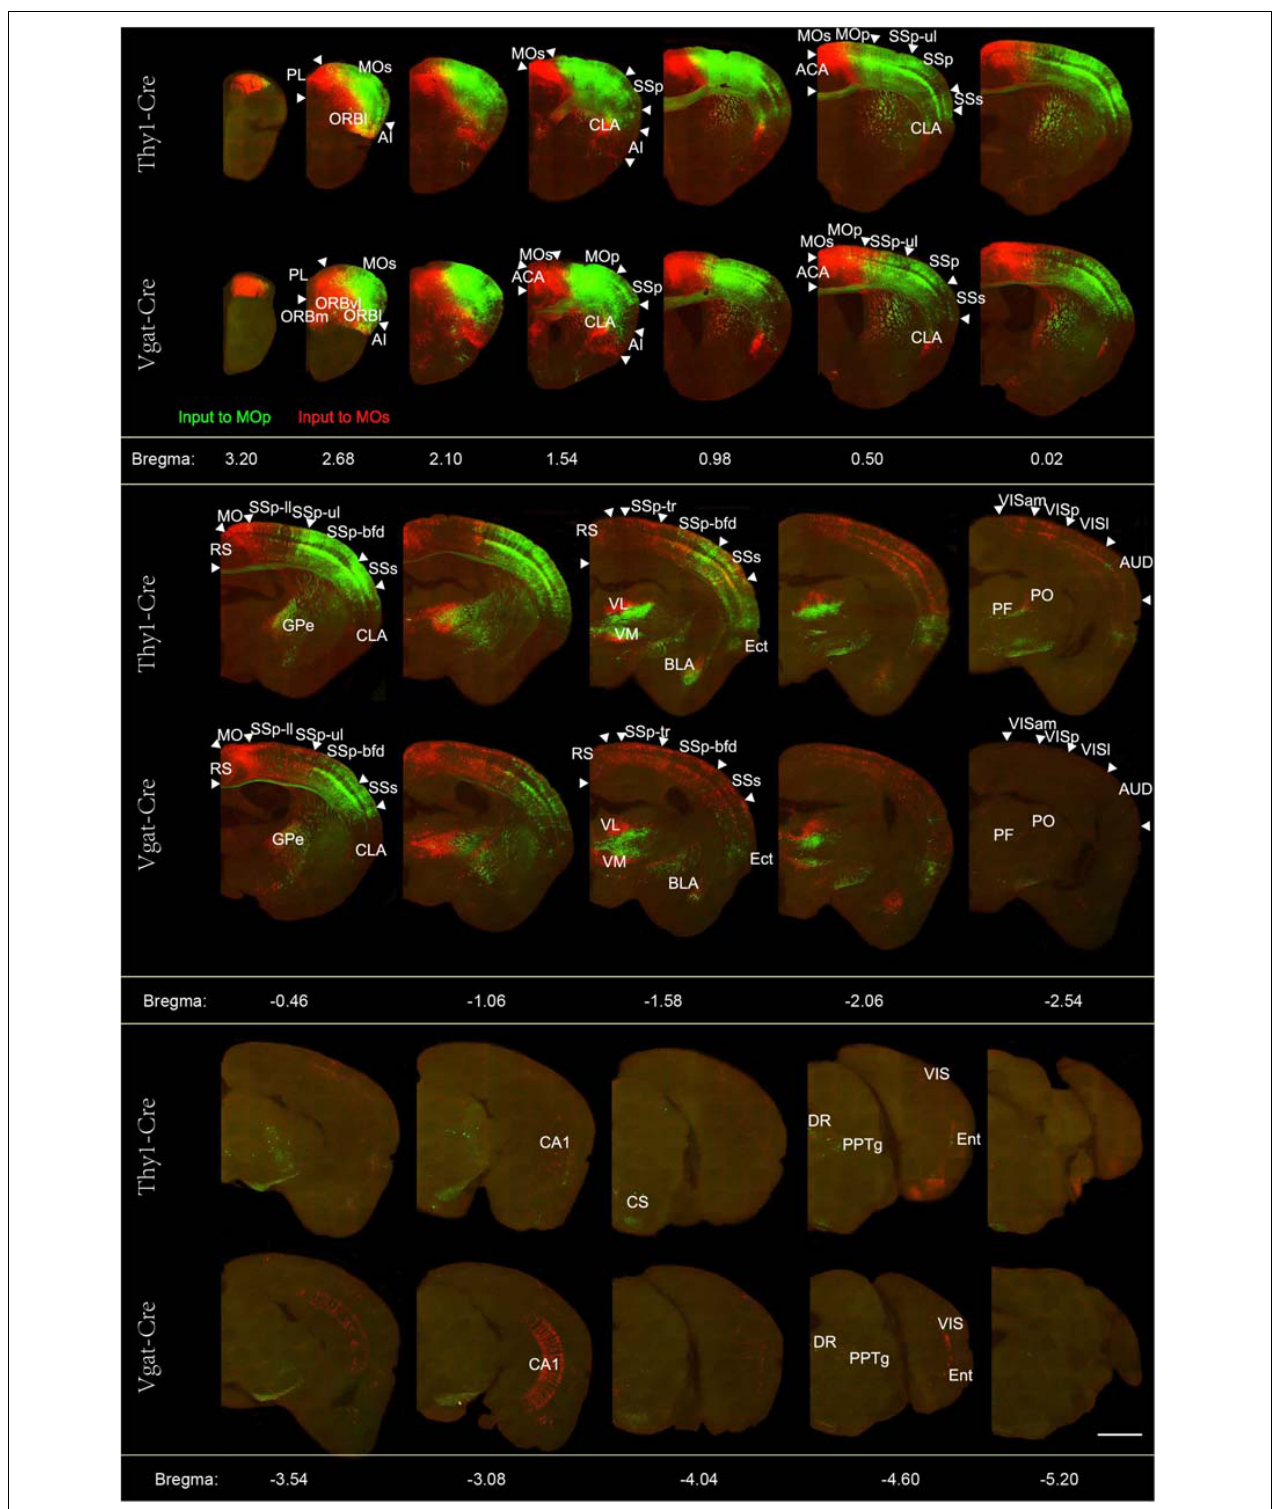
FIGURE 2 | Representative images of selected regions with monosynaptic inputs to the glutamatergic and GABAergic neurons in the motor cortex. Continuous coronal view of maximum intensity projection of the Z stack (50 µ m) across the entire brain. RV-labeled neurons identified by the green signal show the neurons projecting to the Mop, while the red signal indicates the neurons projecting to the MOs. Scale bar = 1 mm.